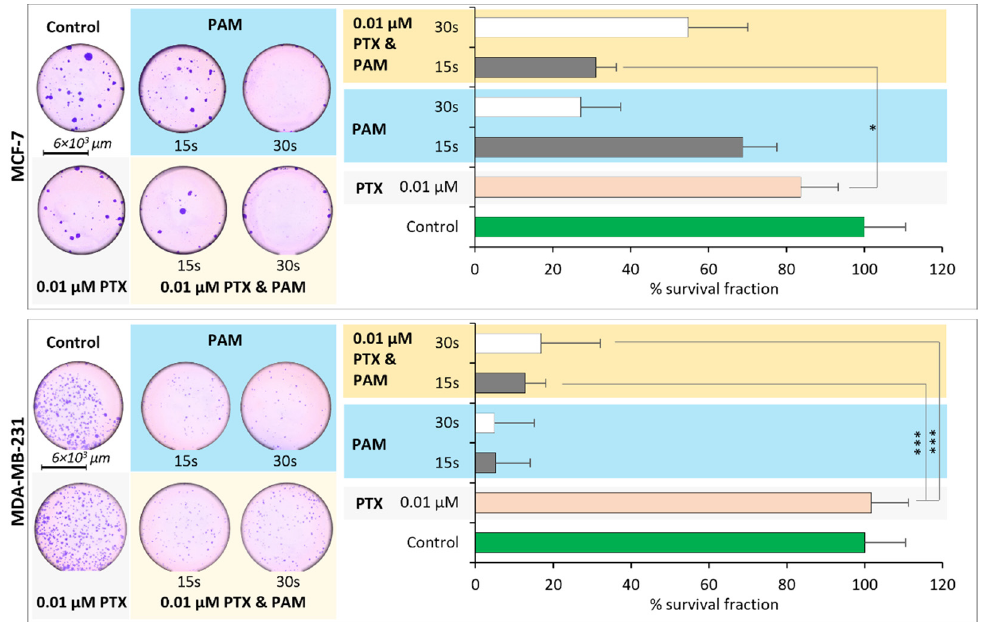
Figure 3. Representative photographs of the MCF-7 and MDA-MB-231 colonies and mean values of the survival fractions as calculated in the case of the control group, PAM 15 s, and PAM 30 s, 0.01 µM PTX, combined treatment (0.01 µM PTX and PAM 15 s and 0.01 µM PTX and PAM 30 s). Data are mean and SEM values ( n = 3). * p < 0.05; *** p < 0.001 (ANOVA).